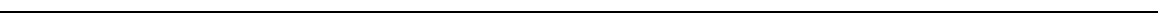
Fig. 2 IL-33 induces IRAK-M phosphorylation and binding to PIN1. a GST PIN1 pulldown assay with DC2.4 cell extracts either non-treated or treated with IL- 33 (100 ng/ml) or LPS (100ng/ml) for 1 h. The GST-PIN1 bound proteins were eluted using reduced gluthatione and probed for IRAK-M. In the lower panel Coomassie blue staining of the blot shows equal amounts of GST or GST-PIN1 that were used for pull-down. b GST-PIN1 pulldown of DC2.4 cell extracts either treated or not with IL-33, followed by treatment in the absence or presence of calf intestinal alkaline phosphatase (CIP) for 30 min at room temperature before subjecting to GST-PIN1 pulldown. c DC2.4 cells were labeled with 10 μ Ci/ml { γ - 32 P}ATP for 3 h. The cells were washed with fresh treated with IL-33 and at the indicated time points were subjected to CO-IP using anti-PIN1 antibody and blotted for IRAK-M. e HEK293 cells